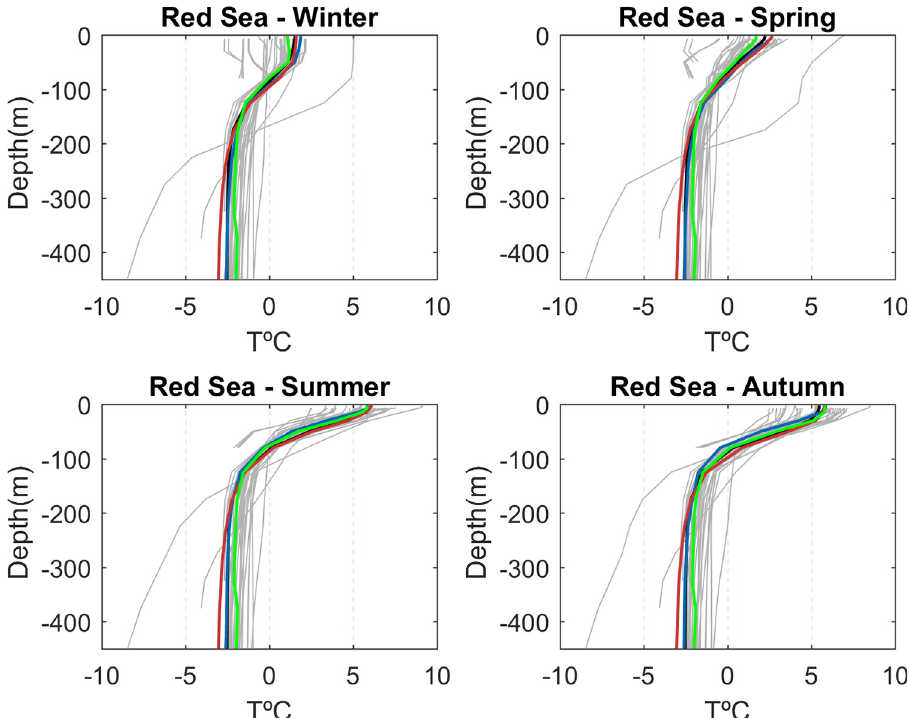
Fig 3. Seasonally averaged vertical profile of temperature anomalies in the Red Sea for the observations (black line), CMIP5 models (grey lines), GLORYS (blue line), KAUST (red line), and the average of the selected GCMs (see “Model Selection” section, green